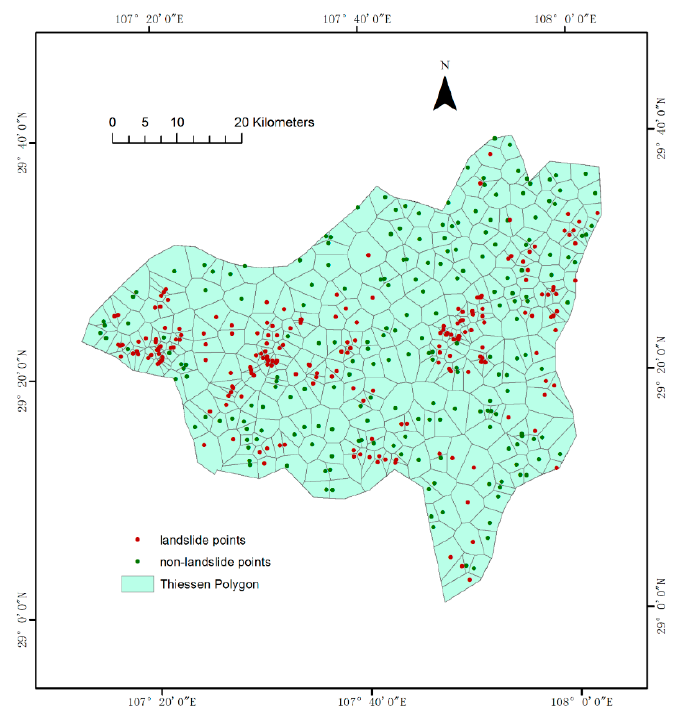
Figure 3. The Thiessen polygons of the landslide point dataset.